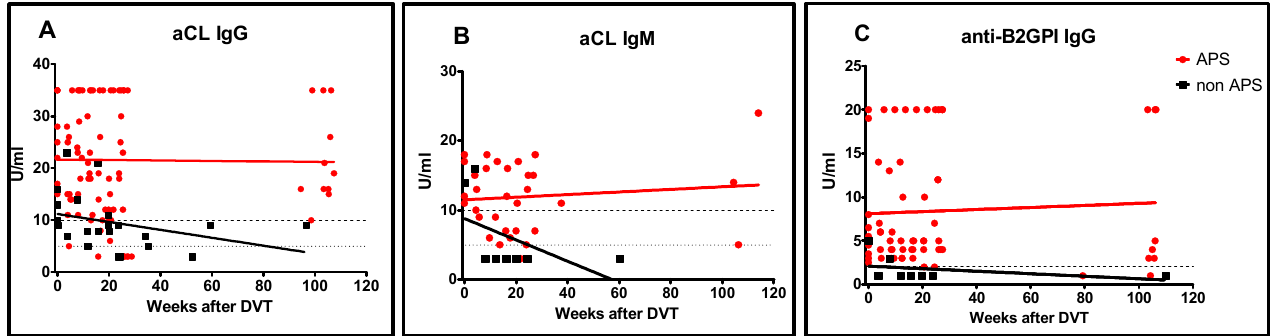
Figure 3. Prospective measurement of aCL IgG ( A ), aCL IgM ( B ) and anti- β 2GPI ( C ) at the time of acute DVT and at repeated measurements over the following 120 weeks. The dark dotted lines represent the 99th percentile dividing the high positive values, and the light dotted line represents the 95th percentile dividing the low positive values.